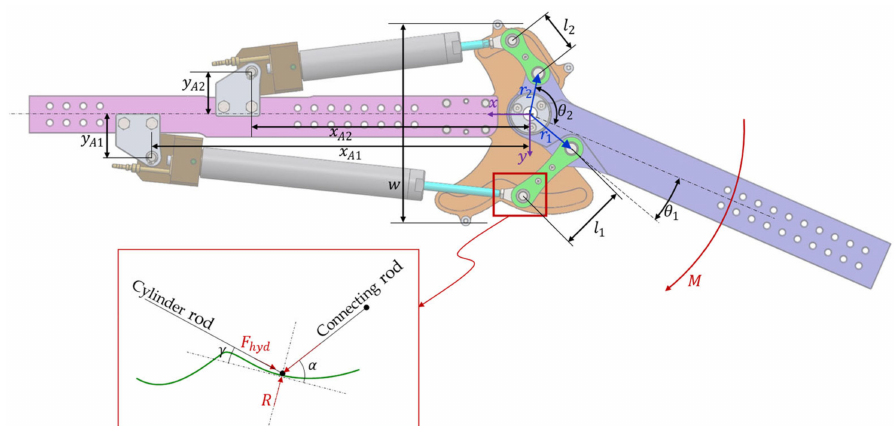
Figure 7. Illustration of critical geometrical dimensions used in the optimization problem. Inset shows the angles formed by the cylinder rod and connecting rod with the tangent of the guide curve at the guide pin.